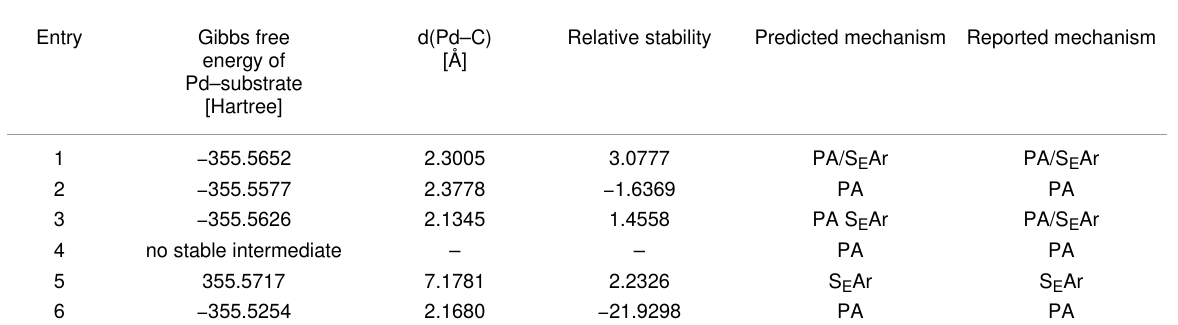
Table 4: A mechanism threshold tested based on the literature examples.